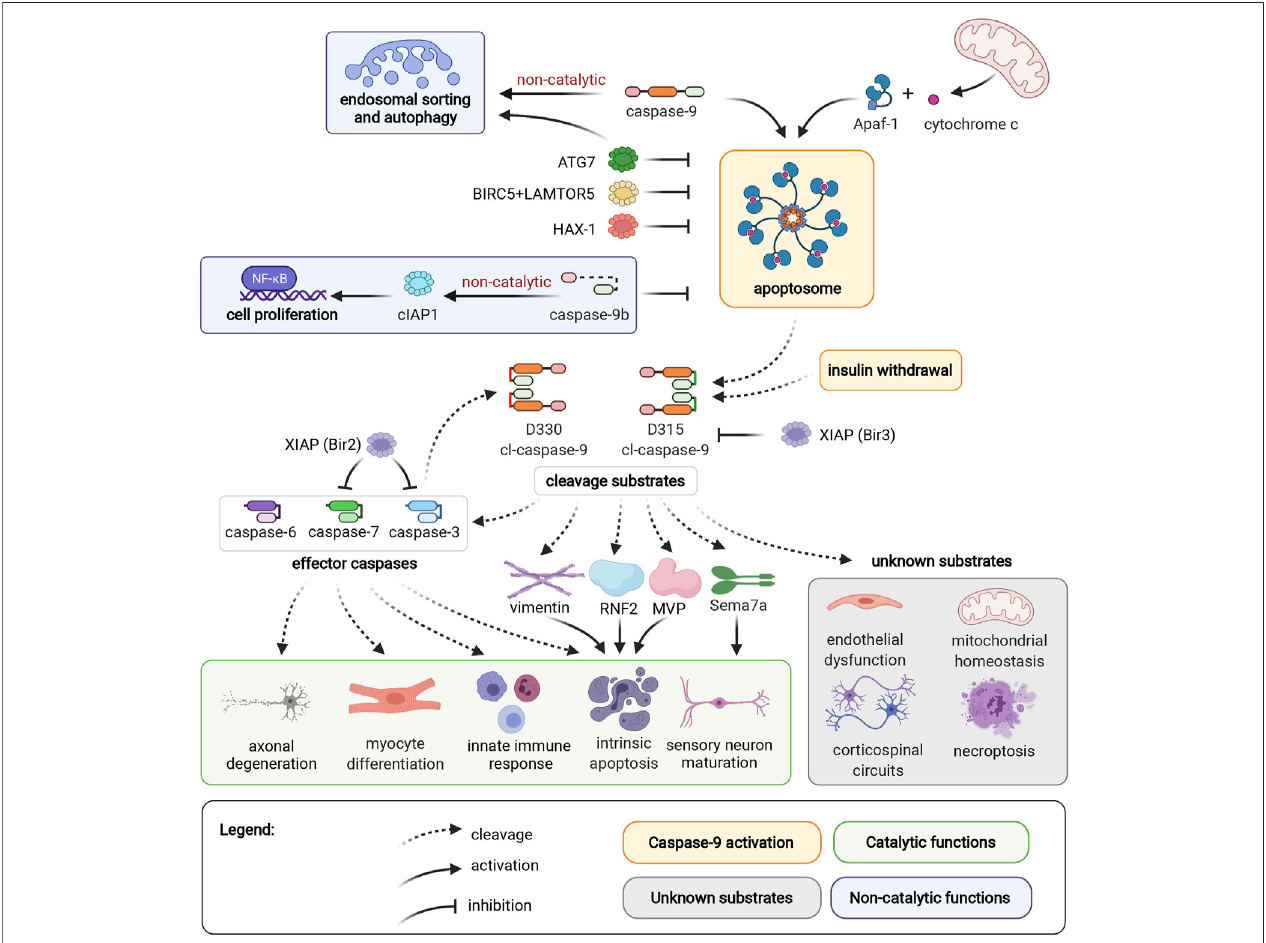
FIGURE 1 | Caspase-9 activation, cleavage substrates, and cellular functions. Caspase-9 can be activated by binding to Apaf-1 in the apoptosome, or by an independent mechanism induced by insulin withdrawal. Endosomal sorting and autophagy are regulated by caspase-9 through a non-catalytic mechanism. ATG7, BIRC5/LAMTOR5complex,and HAX-1inhibitcaspase-9activation.Non-catalytic caspase-9b inhibitscaspase-9 activation,and promotescellproliferationthroughthe NF- κ B pathway. D315 and D330 neoepitopes of caspase-9 are generated by autocleavage, or caspase-3 cleavage, respectively. Caspase-9 substrates include caspases-3,-6,-7,vimentin,RNF2,MVP,andSema7a.Thesecleavageeventsmediateaxonaldegeneration,myocytedifferentiation,innateimmuneresponse,intrinsic apoptosis, and sensory neuron maturation. Caspase-9 mediates endothelial dysfunction, corticospinal circuits, mitochondrial homeostasis, and necroptosis through unidenti fi ed mediator substrates. The Bir3 domain of XIAP inhibits D315 cl-caspase-9, while the Bir2 domain of XIAP inhibits effector caspases-3 and -7. Apoptotic protease activating factor 1 (Apaf1); Autophagy Related 7 (ATG7); survivin (BIRC5); Late Endosomal/Lysosomal Adaptor, MAPK And MTOR Activator 5 (LAMTOR5); HCLS1-AssociatedProteinX-1(HAX-1);RingFingerProtein2(RNF2);MajorVaultProtein(MVP),semaphorin7a(Sema7a);X-linkedInhibitorofApoptosisProtein(XIAP).